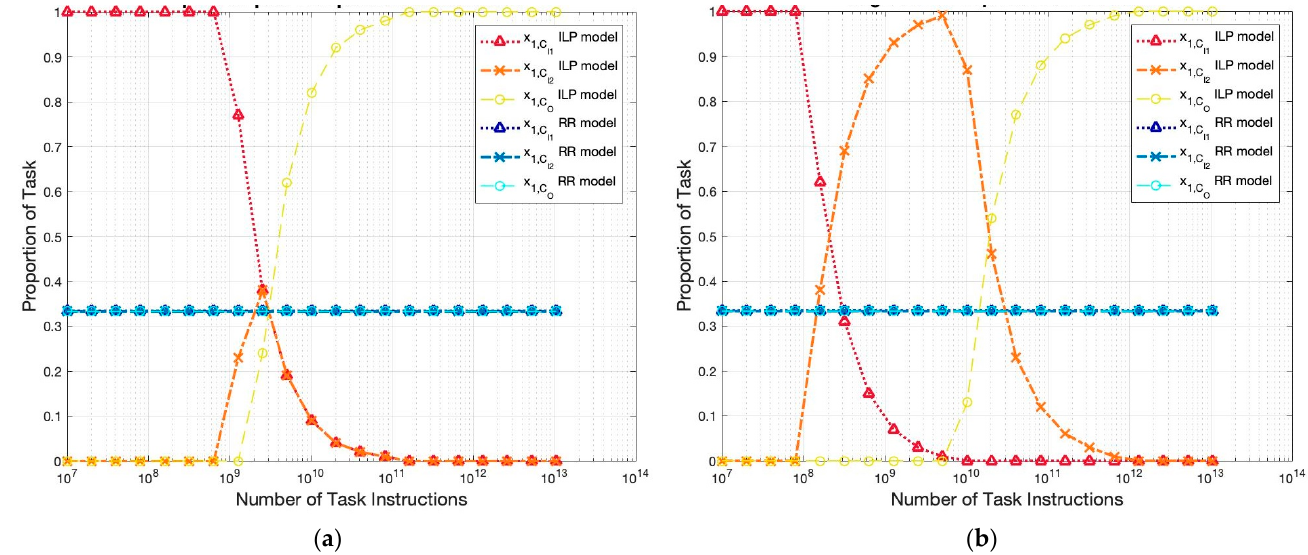
Figure 4. Proportion of task in case study 2: ( a ) peer-to-peer federated cluster scenario; ( b ) edge-core cluster scenario.